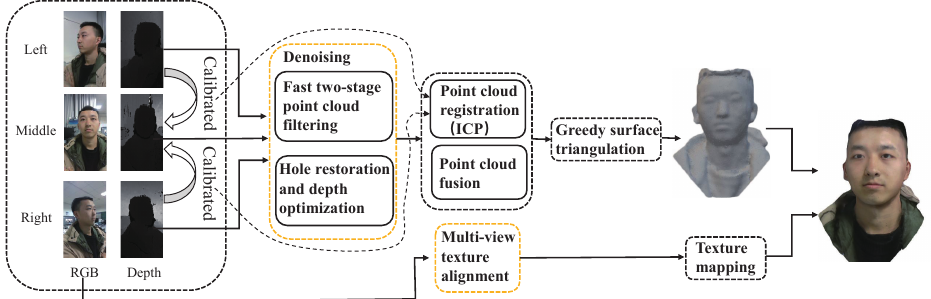
Figure 3. Overview of the face reconstruction